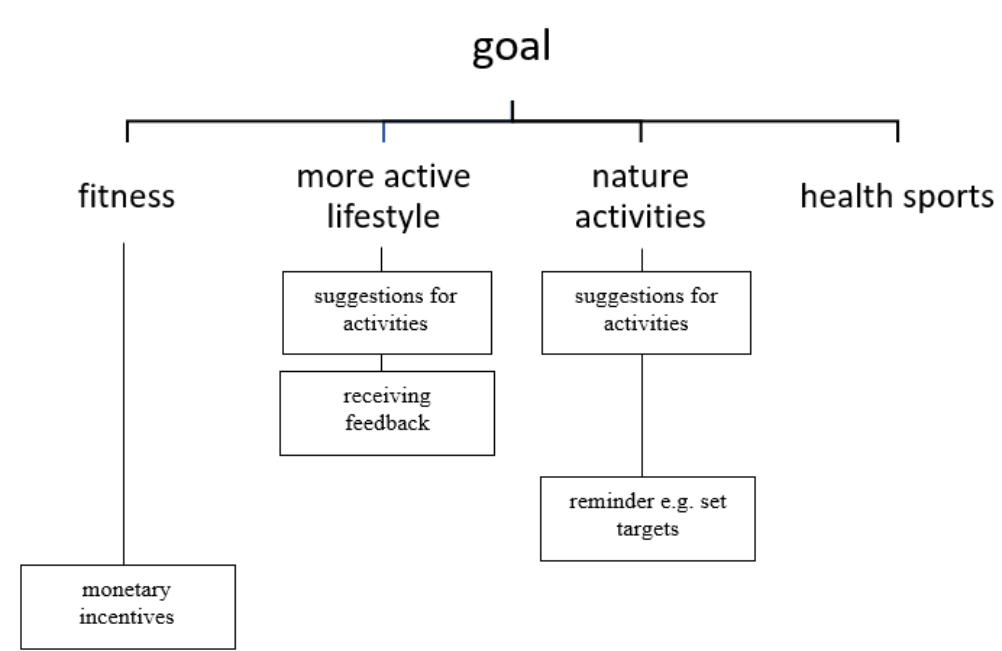
Figure 3. Interest of inactive persons in app features and gamification elements in an app to increase physical activity after conducting a regression analysis.